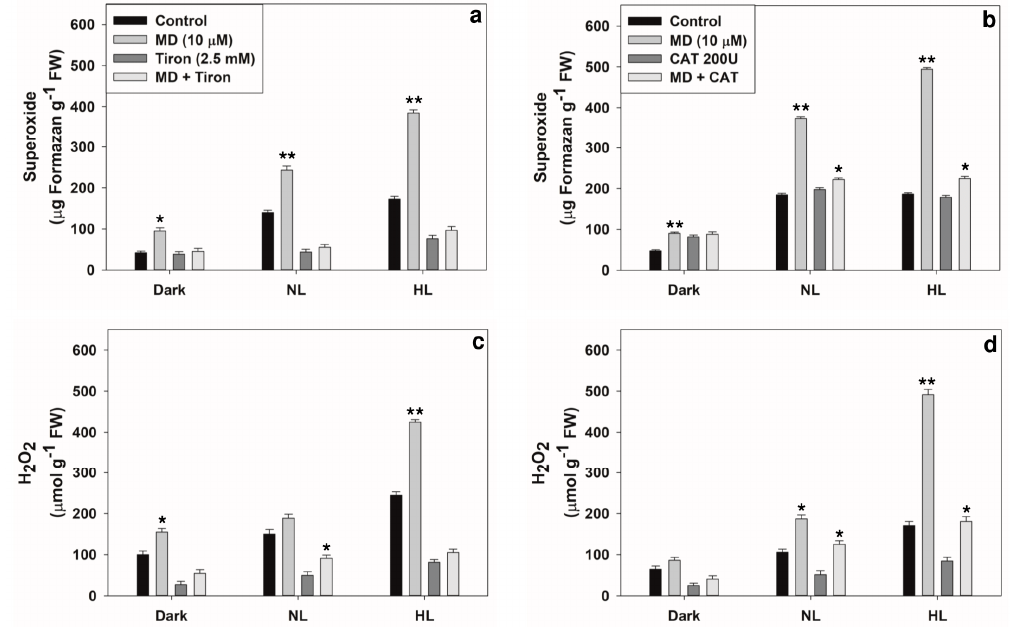
Figure 9. Scavenging ROS, superoxide or H 2 O 2 by Tiron (2.5 mM) or catalase (200 U), respectively, in pea leaf discs after treatment with or without MD. The levels of superoxide ( a , b ) and H 2 O 2 ( c , d ) were determined using NBT and DAB, respectively. * p < 0.05; ** p < 0.001.